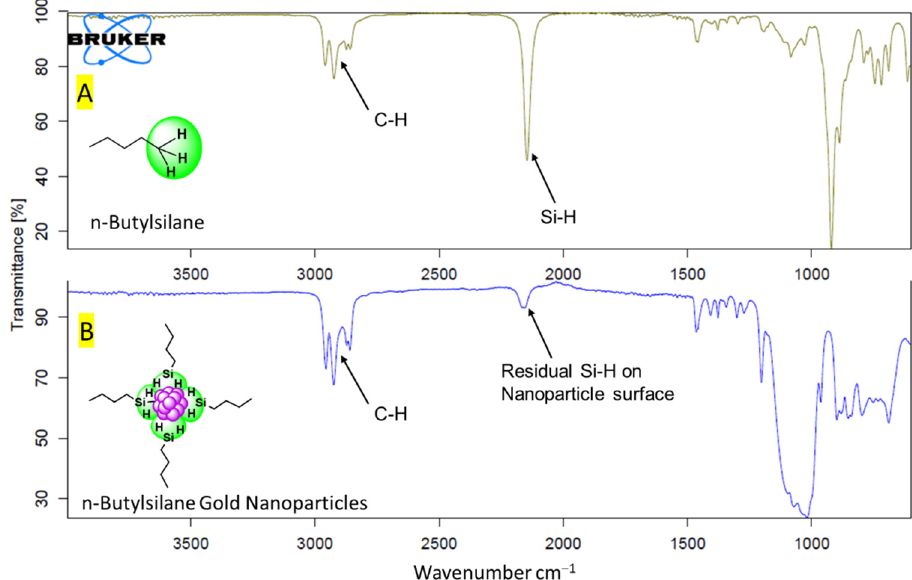
Figure 5. Infrared Spectrum Analysis of ( A ) dried 2-AST gold Nanoparticles vs. ( B ) dried Au Nanoparticles after phase transfer with n-butylsilane.